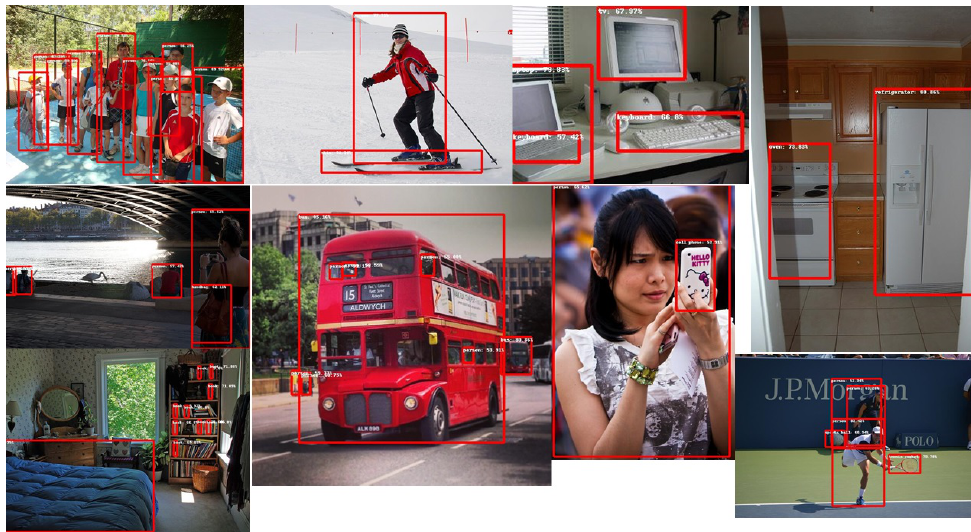
Figure 12. Good inference results.The squares correctly locate object positions and object labels correctly identify object